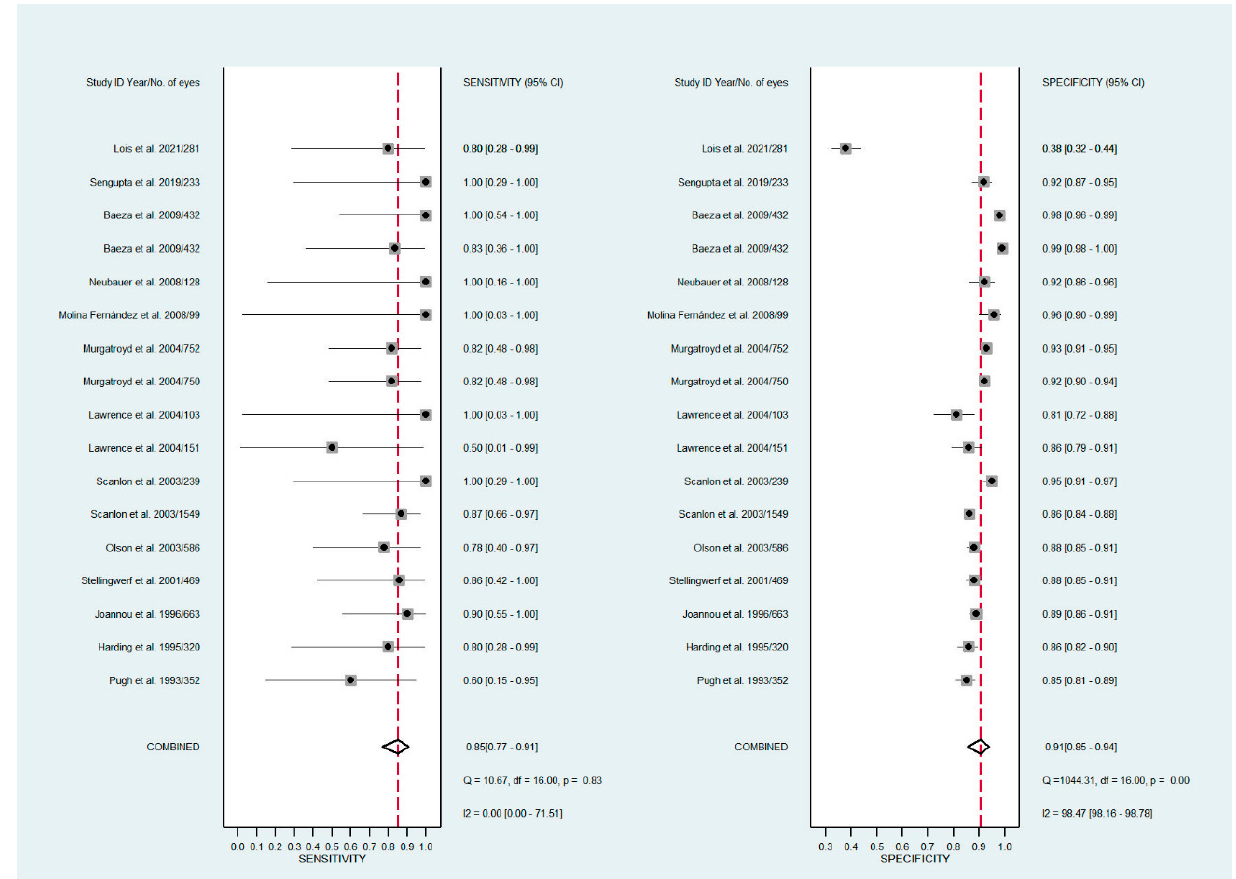
Figure 2. Forest plots for the sensitivity and specificity of mydriatic, non-mydriatic and smartphone-based imaging fundus imaging.